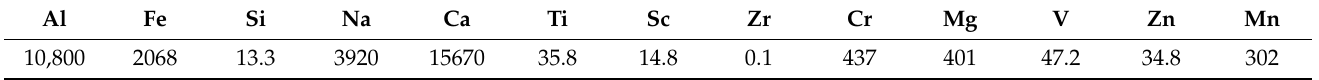
Table 4. Chemical composition of mother liquor from HCl leaching of IDBR, mg/L.